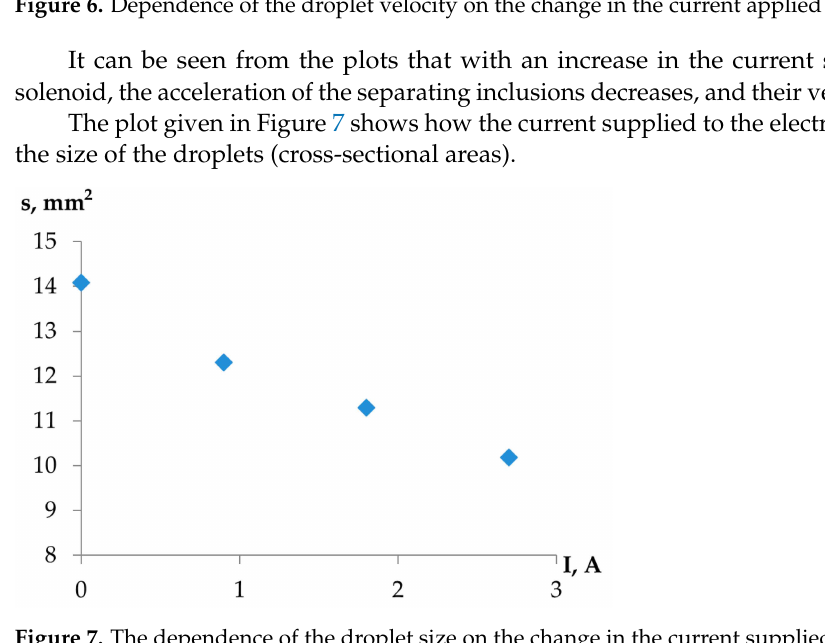
Figure 7. The dependence of the droplet size on the change in the current supplied to the solenoid.